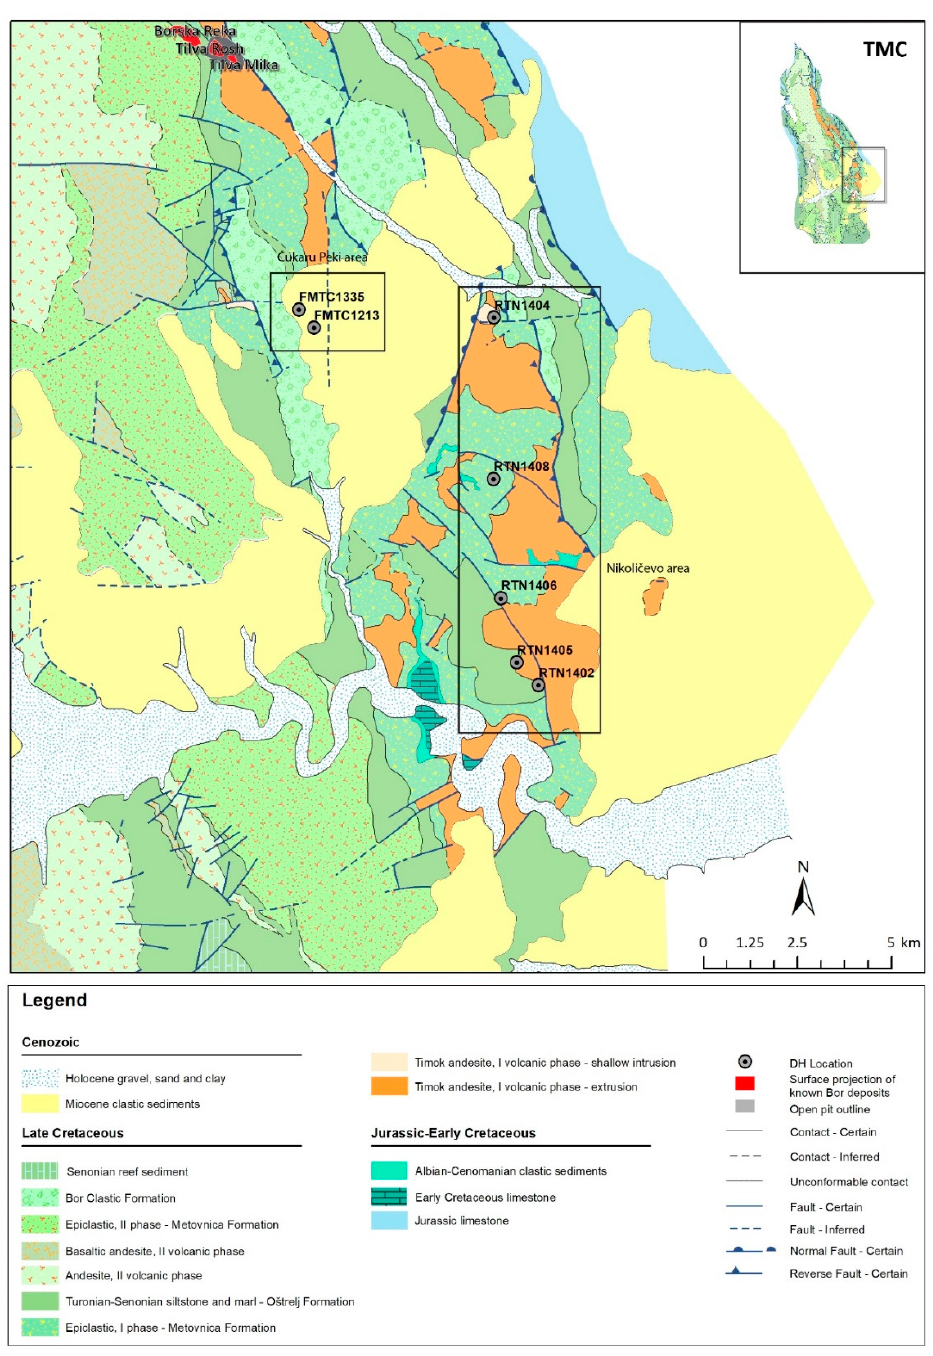
Figure 2. A detailed geological map of the areas of Č ukaru Peki and Nikoli č evo.